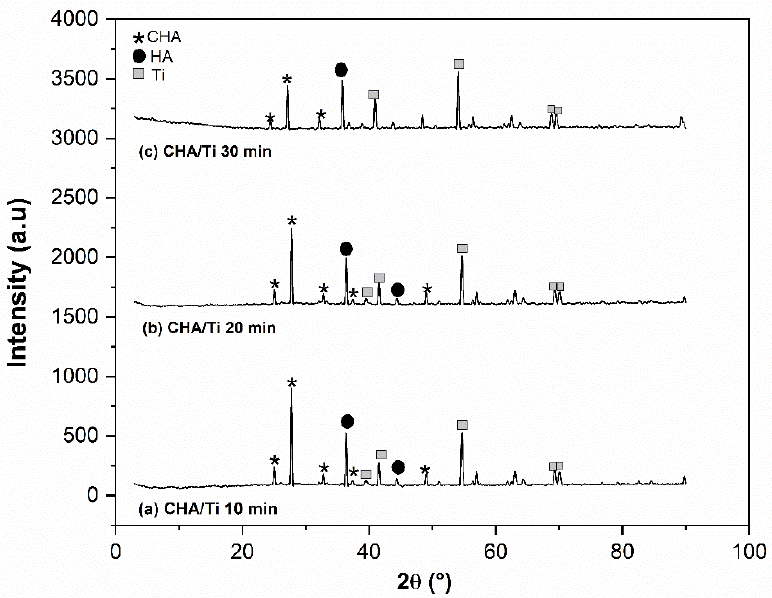
Figure 7. XRD pattern of CHA/Ti coating with immersion times variation (min).